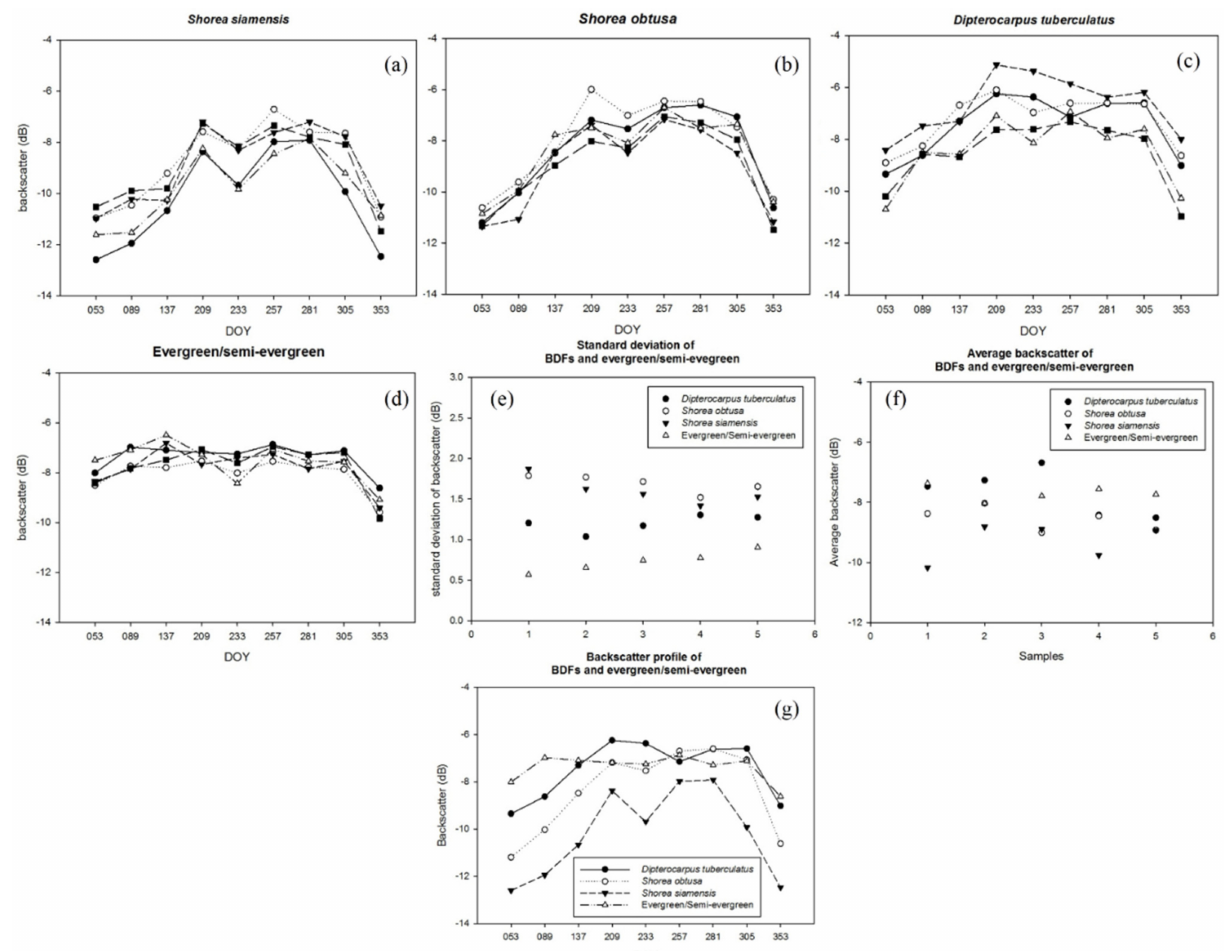
Figure 6. Backscatter profiles of BDFs on multitemporal Sentinel-1A images: ( a ) Shorea siamensis , ( b ) Shorea obtusa , ( c ) Dipte- rocarpus tuberculatus , ( d ) evergreen/semi-evergreen , ( e ) standard deviation backscatter value of BDFs and evergreen/semi- evergreen, ( f ) average backscatter value of BDFs and evergreen/semi-evergreen, and ( g ) comparison of backscatter profile of BDFs and evergreen. DOY (Day of the Year of the Julian